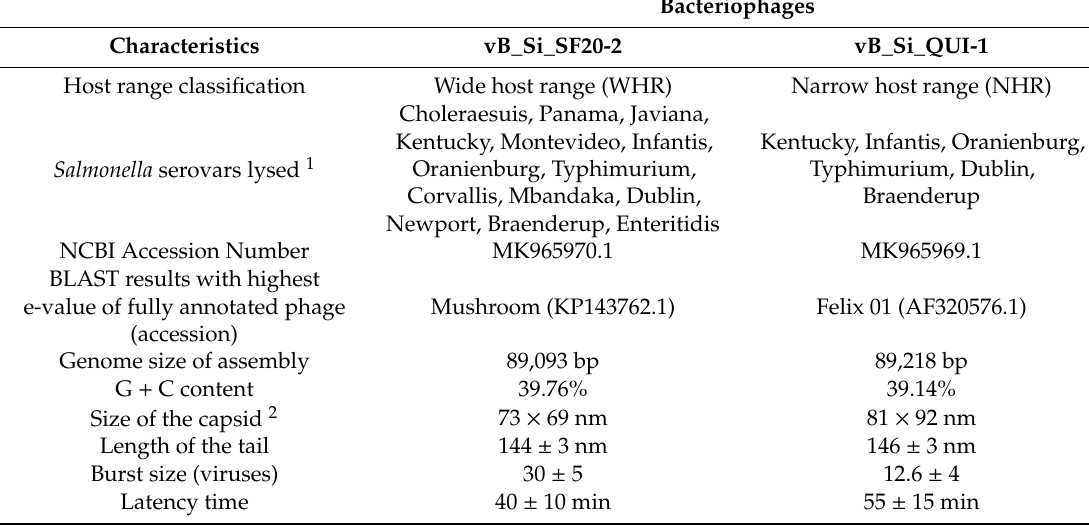
Table 1. Genomic and phenotypic characteristics of wide host and narrow host